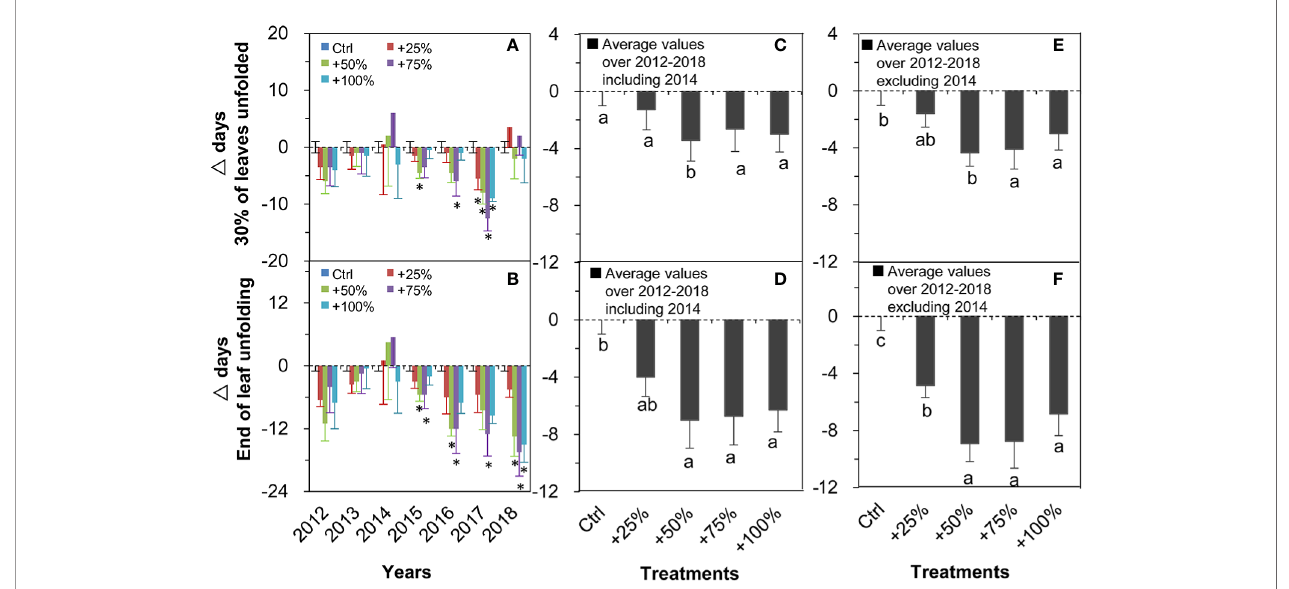
FIGURE 4 | Relative changes ( △ days; mean ± SE) of the two spring events of N. tangutorum after water addition treatments (+25% to +100%) compared with the control (Ctrl). Positive and negative values represent delayed and advanced days, respectively. A, C, E represent the 30% of leaves unfolded event. B, D, F represent the End of leaf unfolding event. * indicates signi fi cant differences at the P < 0.05 level compared with values in control plots.